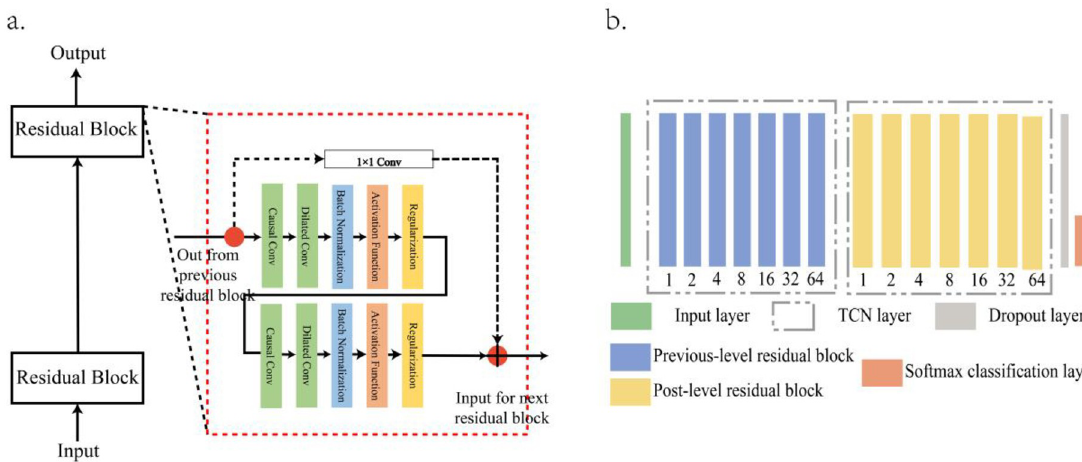
Fig 5. TCN structure, a. The overall structure, b. The network structure.